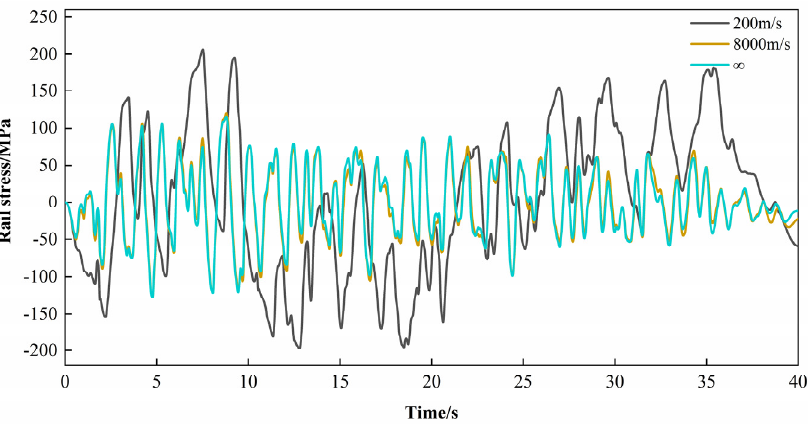
Figure 11. Time-history curve of rail stress at point A under different apparent wave velocities.